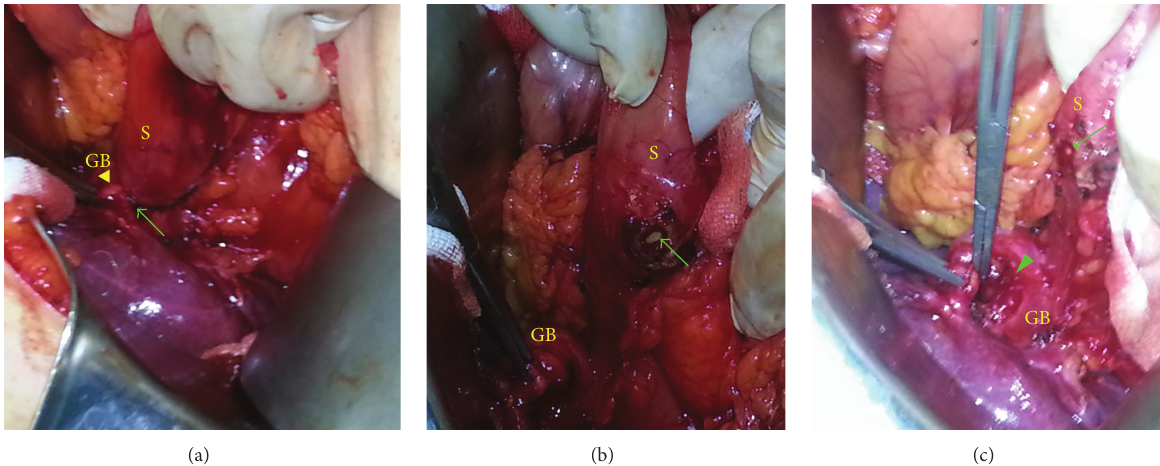
Figure 1: Incomplete cholecystogastric fistula. (a) Fistula tract between the gallbladder and stomach. (b, c) Appearance after fistulectomy. The arrow indicates the fistula opening on the stomach wall. The arrowhead indicates the fistula opening on the gallbladder (GB: gallbladder and S: stomach).